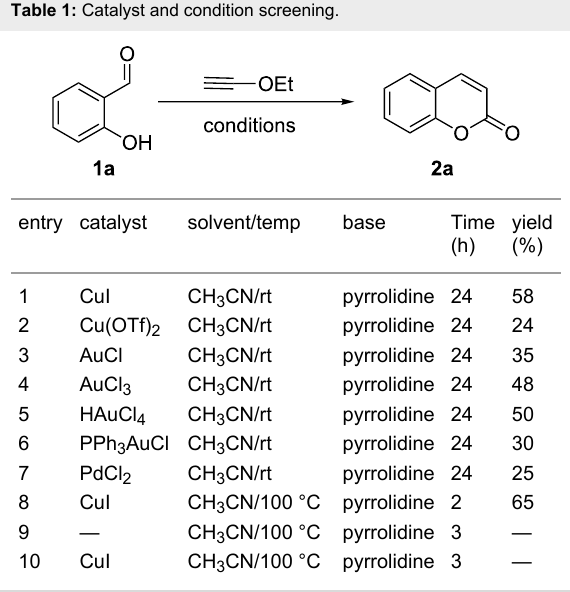
Table 1: Catalyst and condition